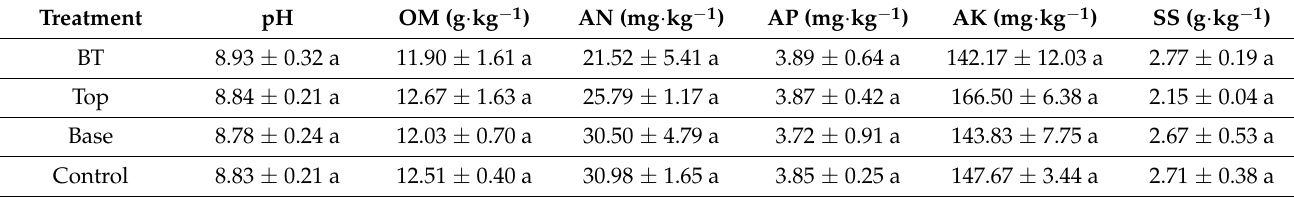
Table 2. Soil chemical properties in different